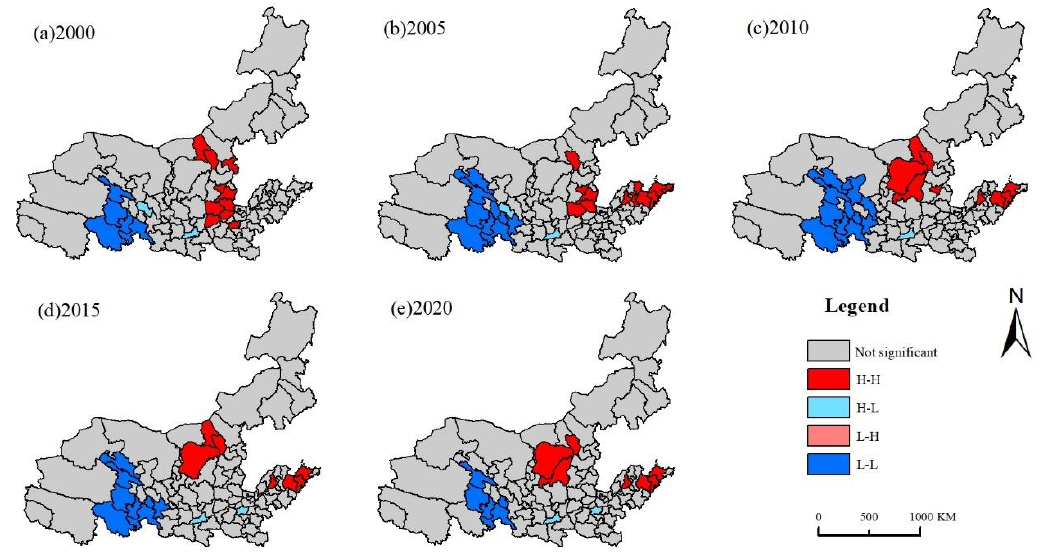
Figure 4. LISA spatial agglomeration pattern of land-use carbon emissions in the Yellow River Basin from 2000 to 2020.